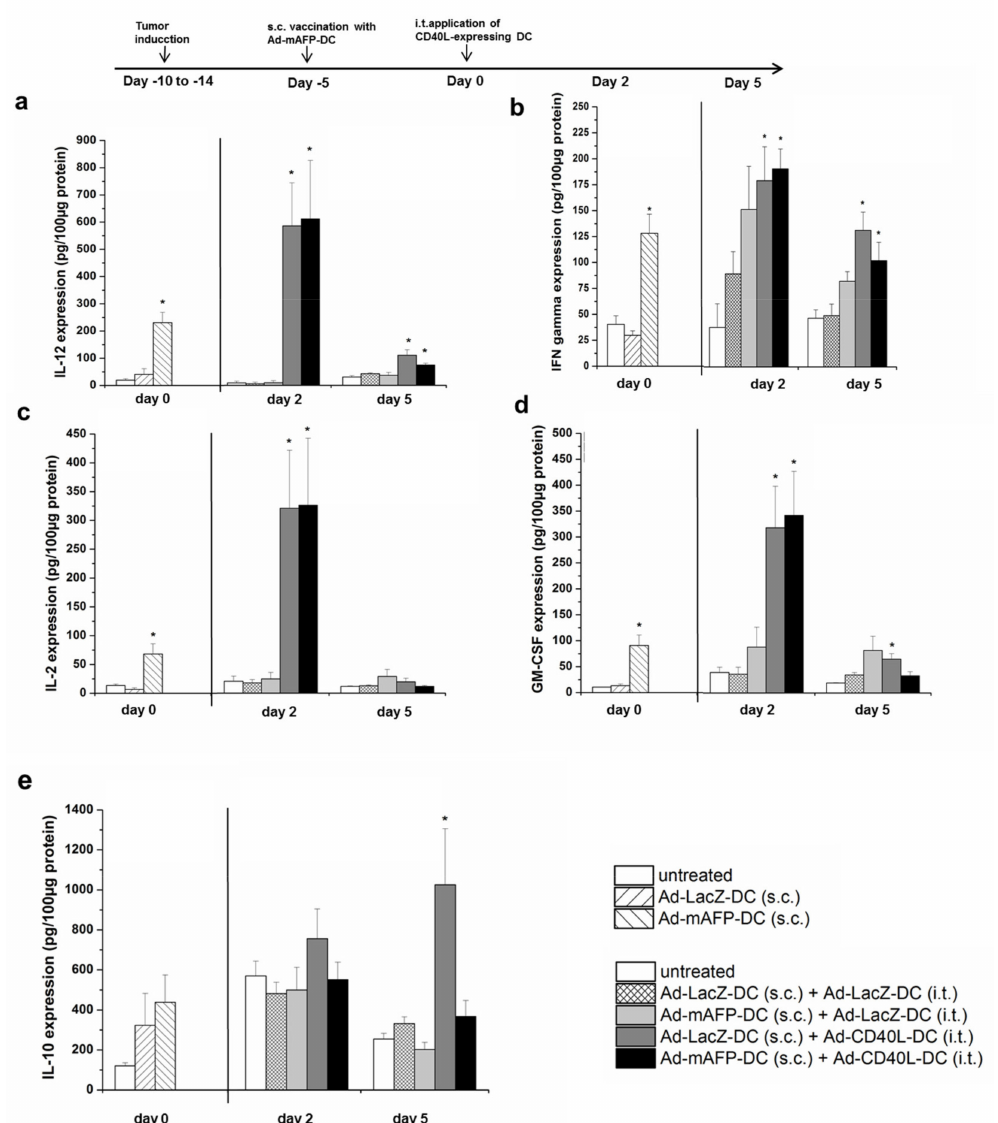
Figure 4. Intratumoral cytokine amount. ( a – e ) Mice were treated with the heterotopic combination of a s.c. vaccination with 10 6 Ad-mAFP-DC or Ad-LacZ-DC followed by an i.t. injection of 10 6 Ad-CD40L-DC or Ad-LacZ-DC. Analysis of cytokine amount within the tumors was performed on day 0 (after the s.c. vaccination before i.t. injection of Ad-CD40L-DC), on day 2 and 5 after the i.t. injection of Ad-CD40L-DC. Amounts of IL-12, IFN- γ , IL-2, GM-CSF and IL-10 in tumors were measured via ELISA Results represent means ± SEM of three independents experiments ( n = 8). (* p < 0.05 compared to s.c.-Ad-LacZ-DC/i.t.-Ad-LacZ-DC group). Significance was determined using the